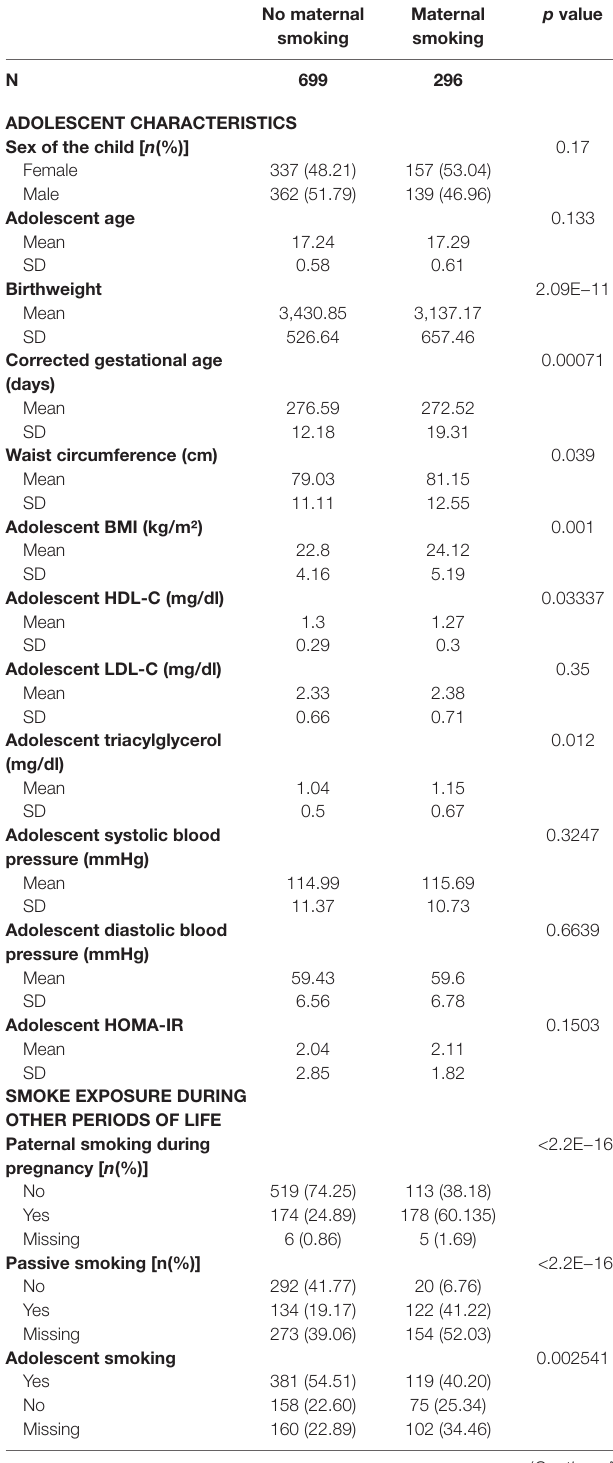
TABLE 1 | Characteristics of the participants of the Raine Study. The p value refers to chi-square test results for categorical and t -test/Wilcoxon test for continuous